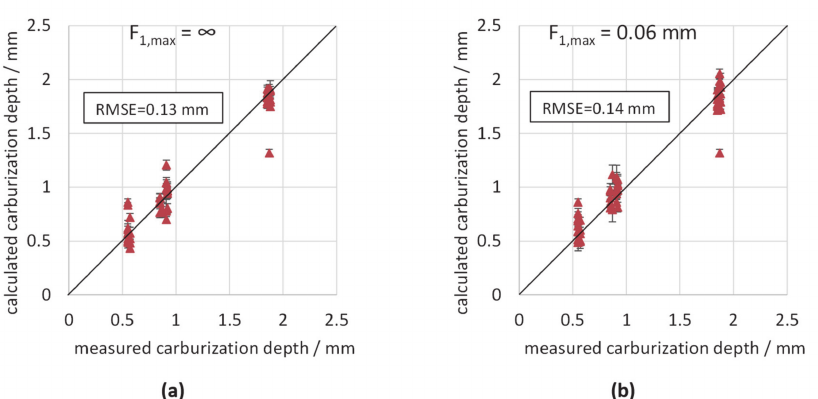
Figure 11. Correlation of micromagnetic determined and actual measured carburization depth of the test data set without limitation of the maximum error effect ( a ) and with limitation to 0.06 mm ( b ).